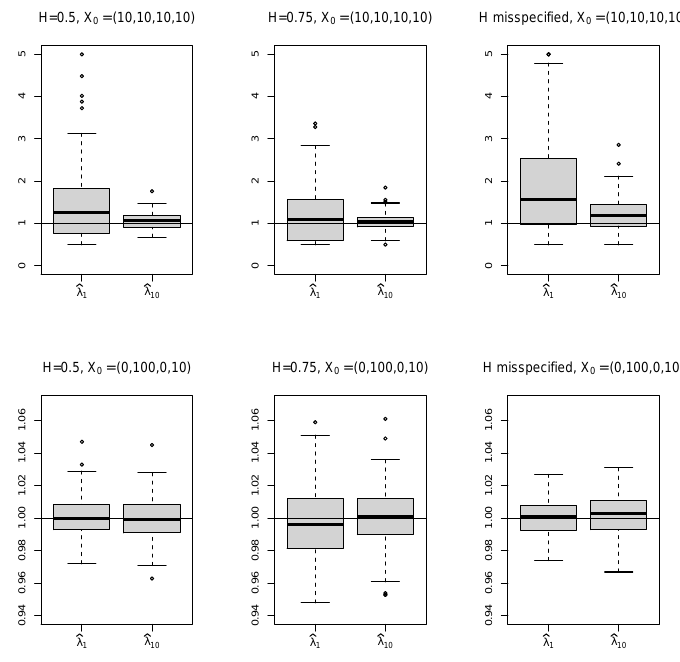
Figure 5. Boxplots of the estimated λ in Example 1 for time horizons T = 1 (denoted by (cid:98) λ 1 ) and T = 10 (denoted by (cid:98) λ 10 ) calculated for 100 samples in every case considered; the horizontal line shows the true value of the estimated parameter λ = 1.